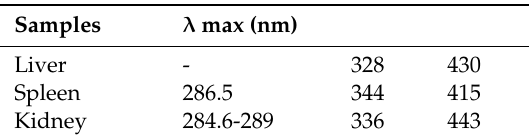
kidney samples of piglets fed with a control or 5% GP